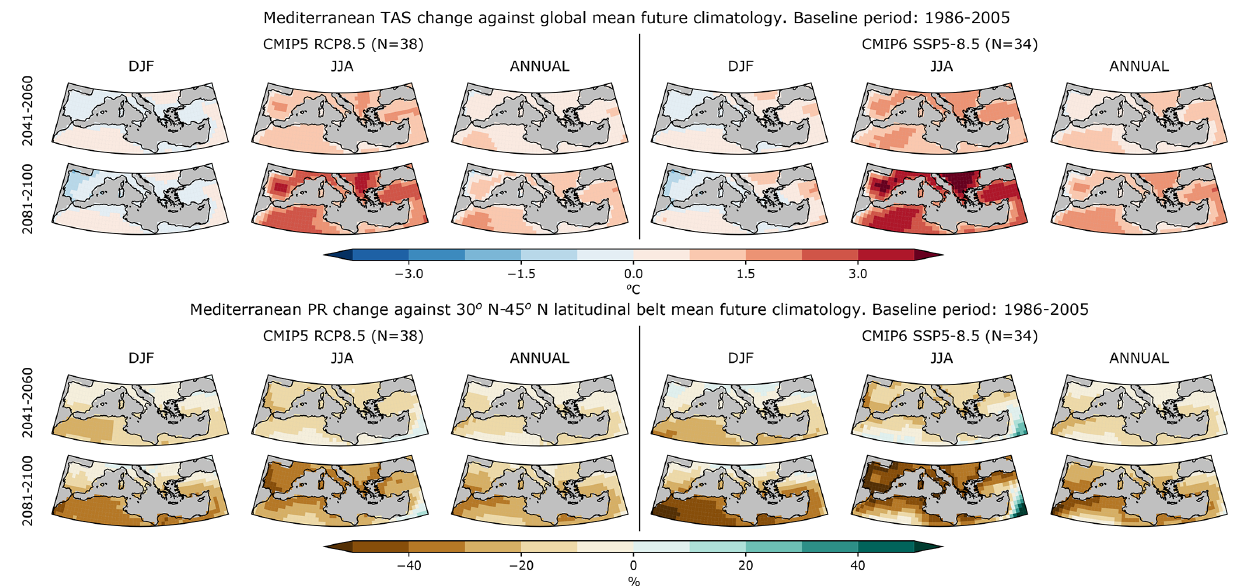
Figure 2. Mediterranean region TAS (upper rows) and PR (lower rows) change differences with respect to the mean global temperature change and the mean 30–45 ◦ N latitudinal belt precipitation change respectively. The changes for the periods 2041–2060 (first and third row) and 2081–2100 (second and fourth row) are evaluated against the 1986–2005 mean. The differences are shown for the CMIP5 (left) and CMIP6 (right) DJF, JJA and annual mean projections (columns) under the high emission scenario RCP8.5 and SSP5-8.5 respectively. N indicates the number of models included in the ensemble mean.